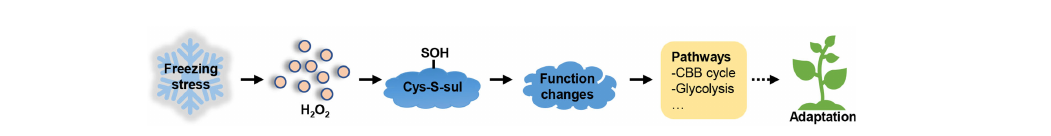
FIGURE 7 Schematic representation of the metabolic response induced by freezing stress. Under freezing stress, H2O2 accumulation induces sulfenylation of proteins, consequently affecting their functions, such as enzyme activity and binding ability. The modi fi ed proteins are involved in several metabolic processes, including CBB cycle and glycolysis, which further help the plants adapt to freezing